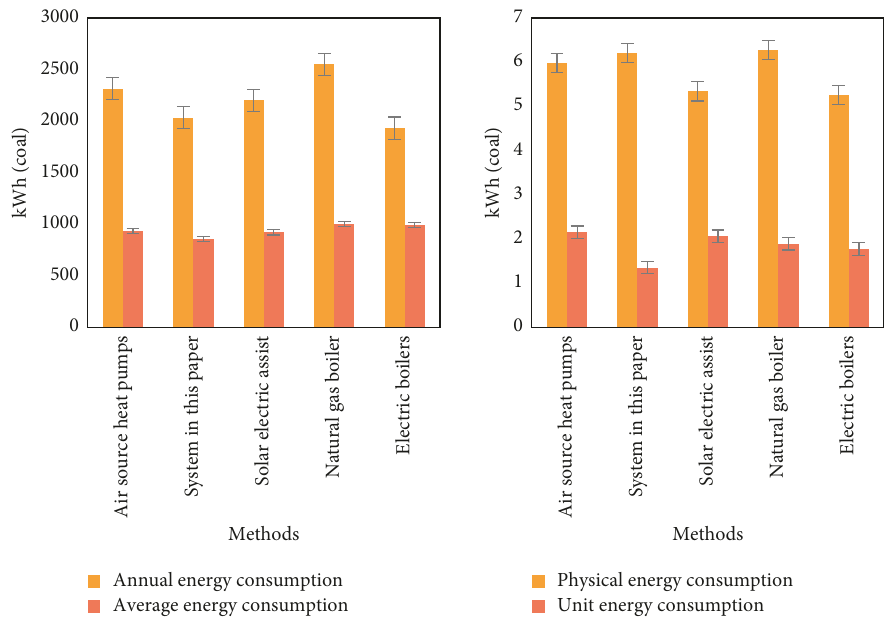
Figure 5: Energy consumption ratio of different preparation methods.